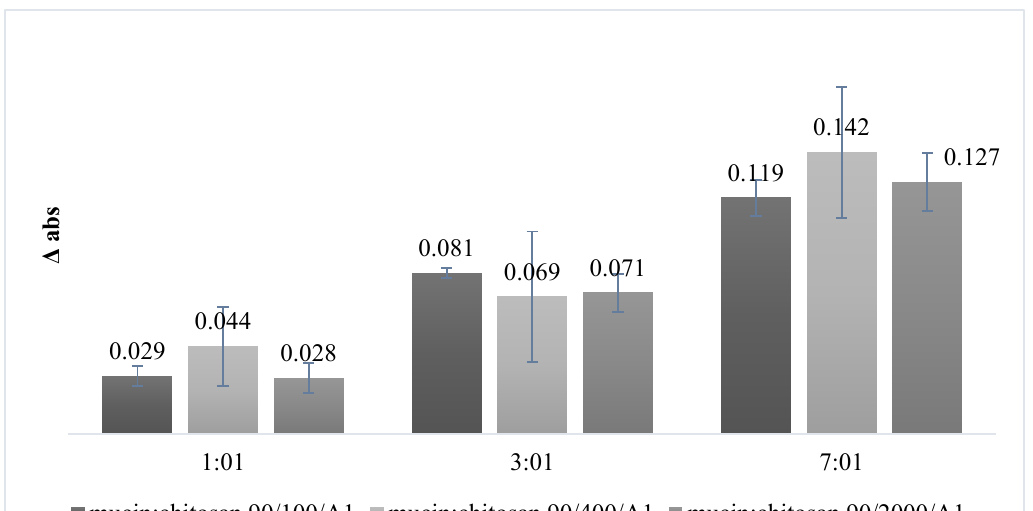
Figure 3. Change in absorbance of different mixtures of mucin:chitosan ( w / w ) (01:01, 03:01 and 07:01 w / w ), using three different types of chitosan (90/100/A1; 90/400/A1; 90/2000/A1).